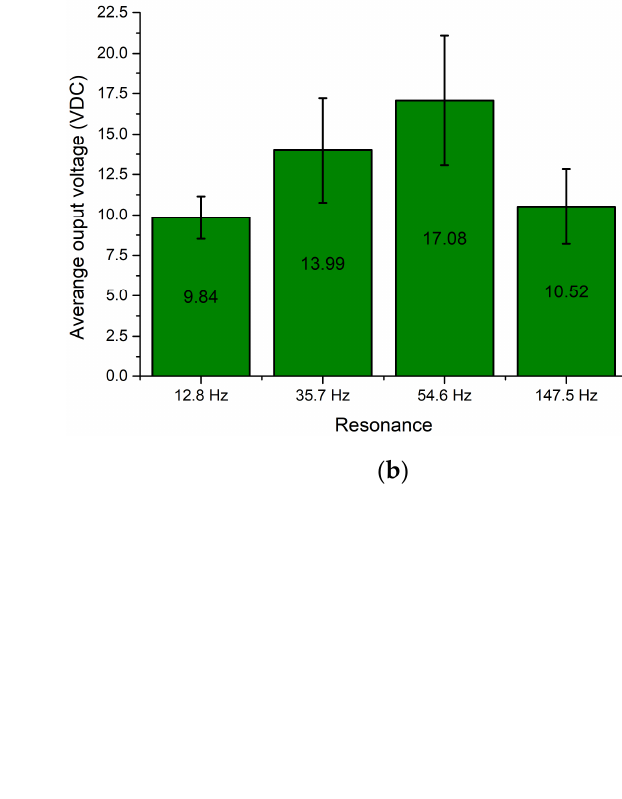
Figure 18. Frequency—voltage—and angle of excitation motion characteristics of the energy har- vester with different loads; ( a )—load equal to 1 MΩ; ( b ) —load equal to 500 kΩ; ( c )—load equal to 250 kΩ.